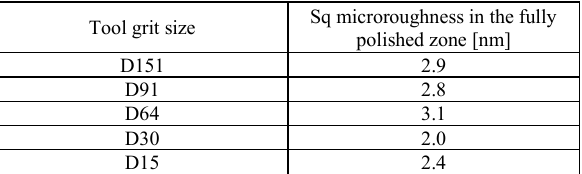
Table 7 . Microroughness Sq in the fully polished zone.